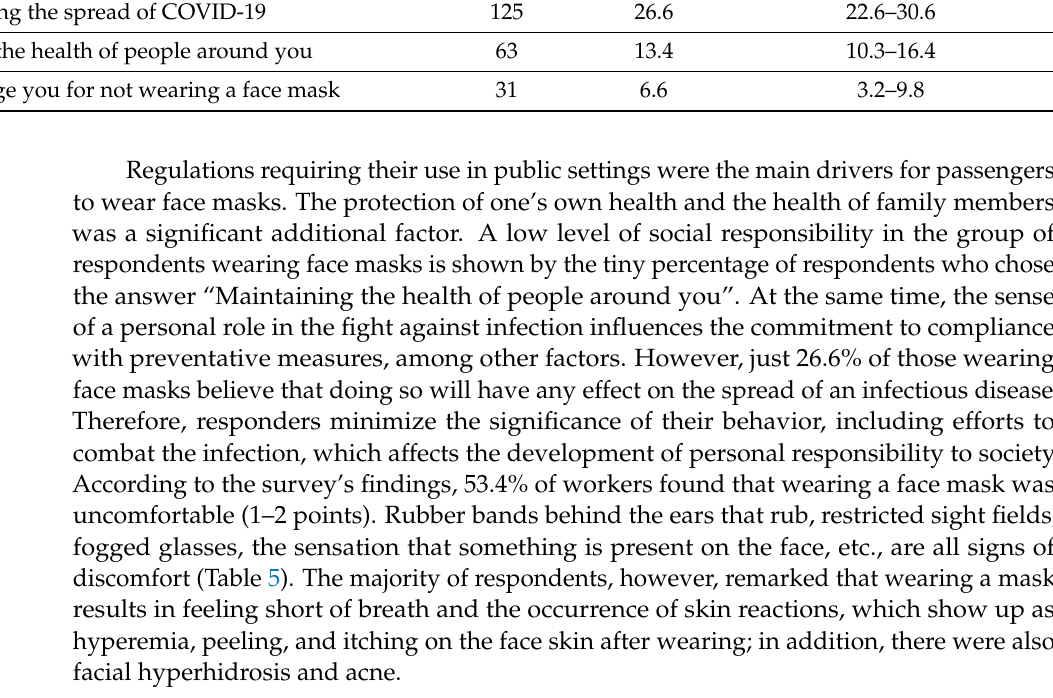
Table 5. A subjective assessment of adverse reactions to and discomfort toward wearing a face